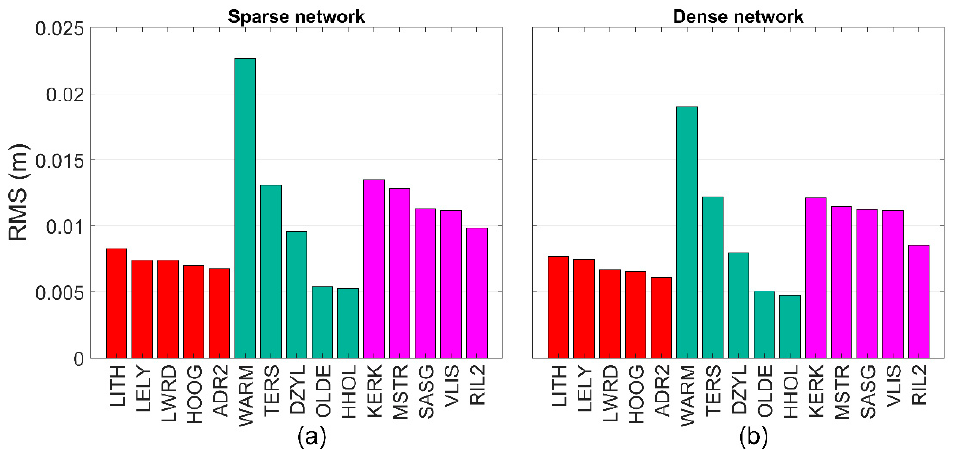
Figure 11. Average RMSE of the user stations in ( a ) the sparse and ( b ) the dense network. Stations from the left to the right are sequential 5 inside the network, 5 on the edge of the network and 5 outside the network.